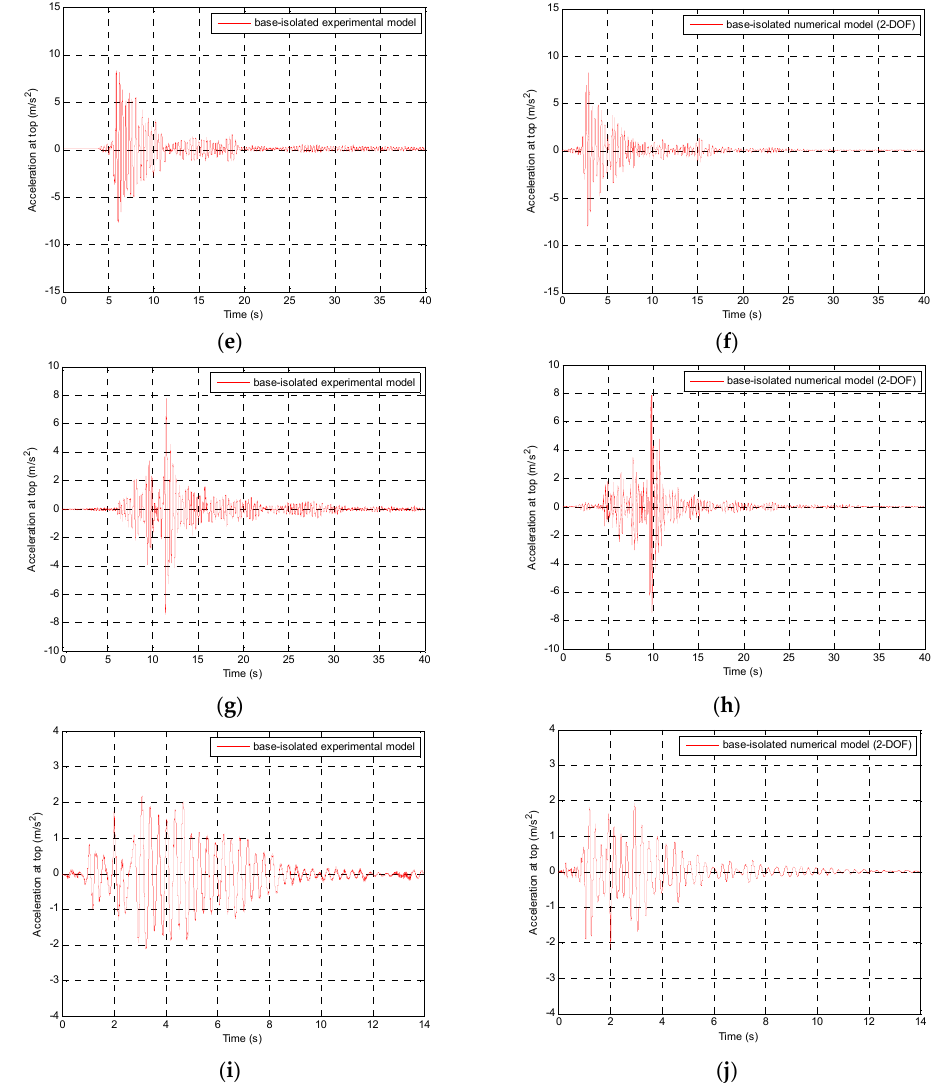
Figure 6. Experimentally determined ( left ) and numerically obtained ( right ) time-acceleration history plots for the base-isolated single-storey model during different ground motions: the 1940 El Centro earthquake ( a , b ), the 1971 San Fernando earthquake ( c , d ), the 1989 Loma Prieta earthquake ( e , f ), the 1994 Northridge earthquake ( g , h ), and the 2002 Polkowice mining tremor ( i , j ). Table 2. Results of the seismic tests for the single-storey structure model . Table 3. Results of the seismic tests for the single-storey structure model.